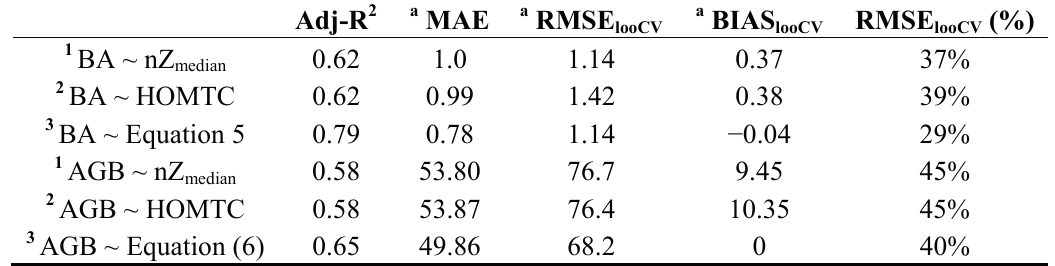
Table 4. The accuracy of prediction in the models for the estimation of AGB and BA. Both regression equations use both the peak-based metric (nZ) and pulse-based metric (i_tot). Adj-R